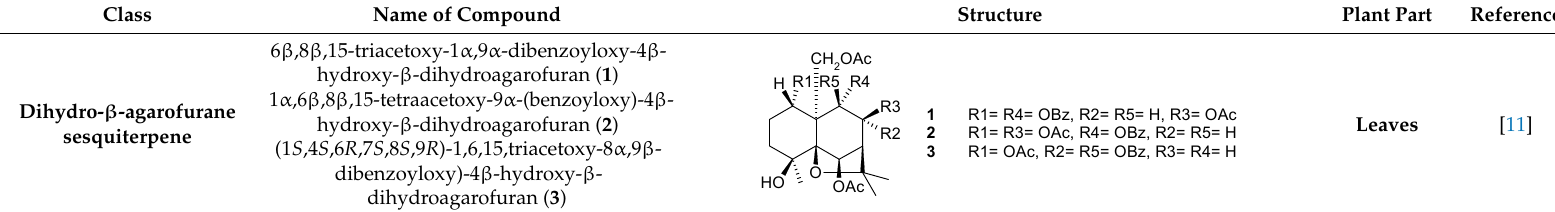
Table 1. Compounds isolated from Maytenus macrocarpa